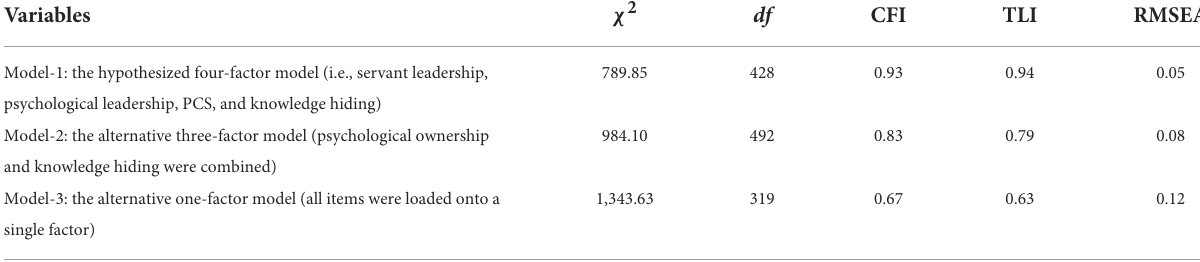
TABLE 1 Comparisons of the CFA Results. Variables